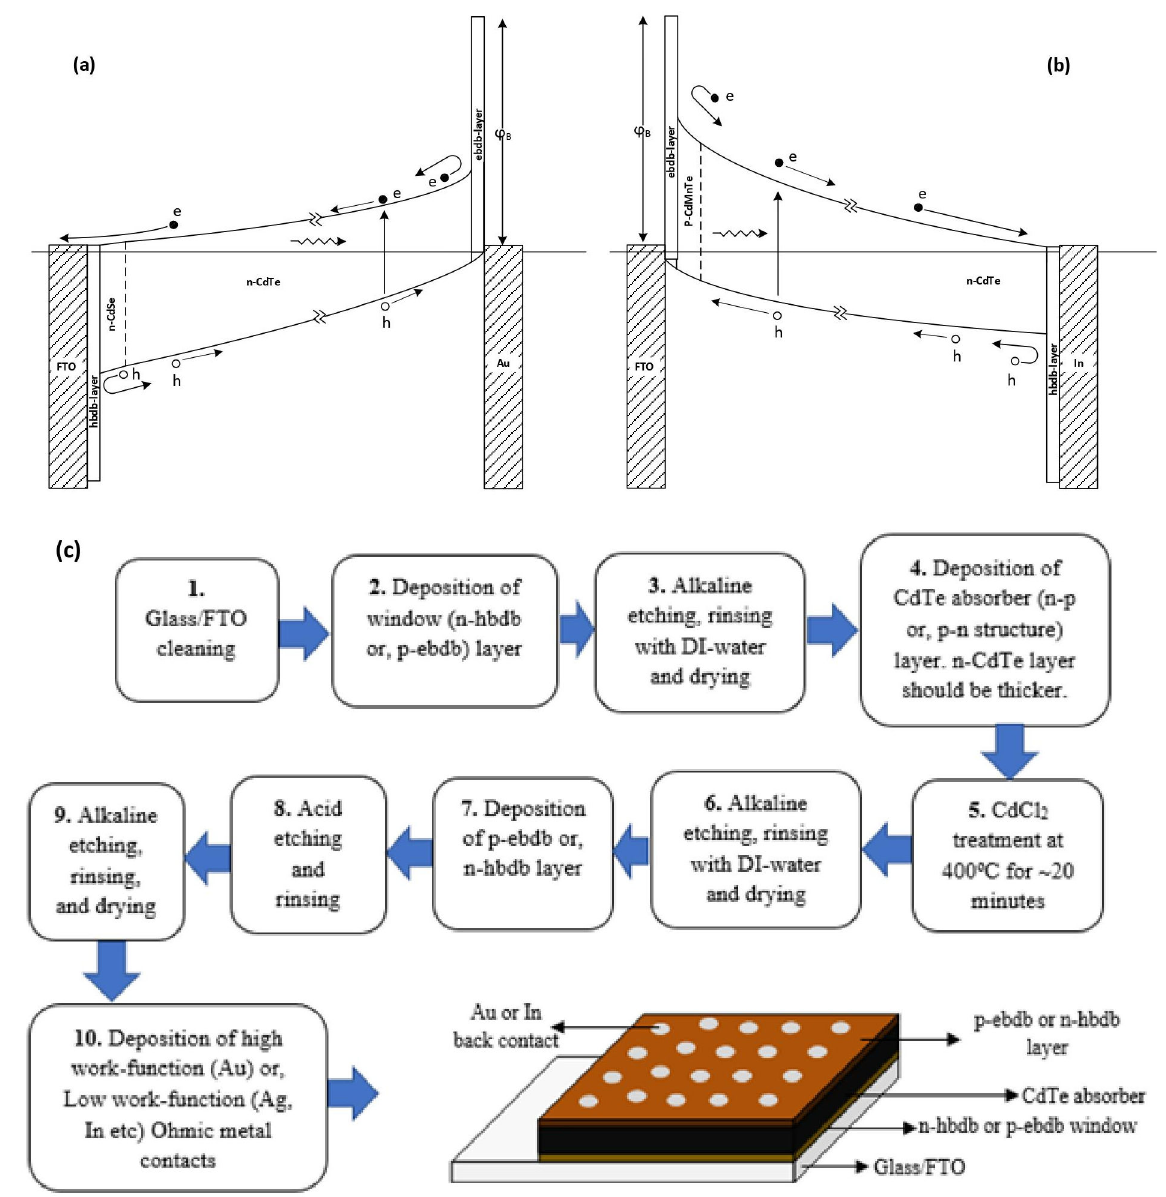
Figure 15. Main features ( a , b ) and basic fabrication steps ( c ) required for a good PV active device. Both electrical contacts are ohmic contacts, and any light-absorbing material or device structure can be incorporated so that the slope of the device structure (internal electric field) is strong